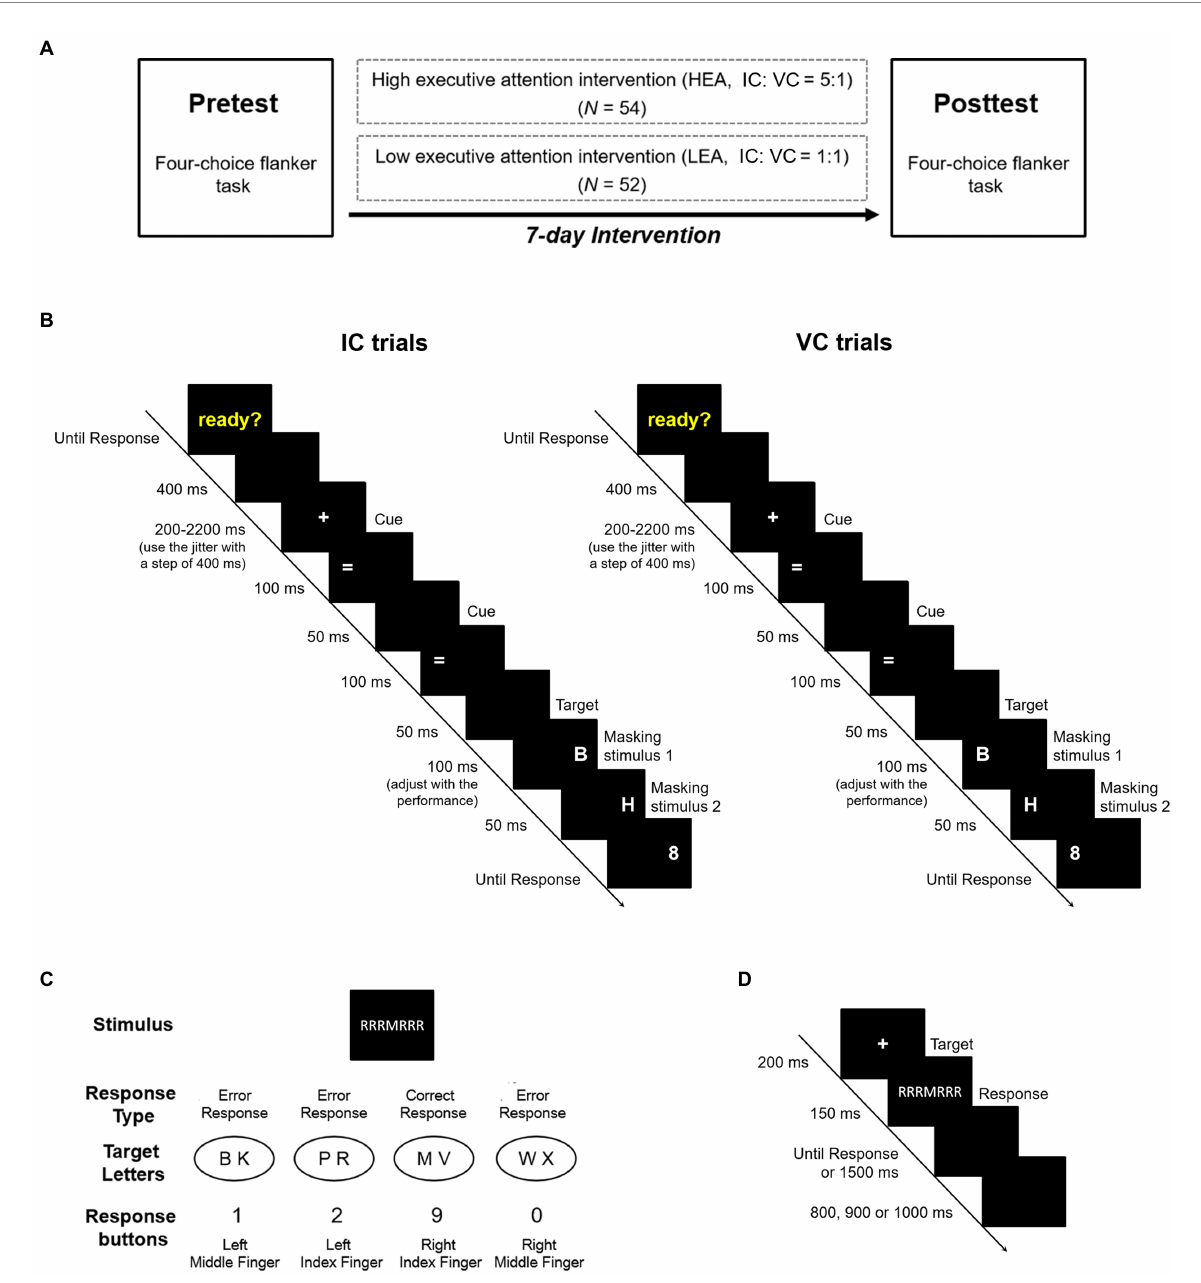
FIGURE 1 (A) Experimental design. (B) The Posner cueing paradigm. The sequence and time course of invalid cue (IC) and valid cue (VC) trials in the task. (C) Stimulus–response mapping in the four-choice flanker task. Each of the four response buttons corresponded to two target letters. In the sample shown, if a response was provided with the right index finger, it would be classified as a correct response. If a response was provided with the remaining fingers, it would be classified as an error response. (D) The four-choice flanker task. The sequence and time course of one typical trial in the